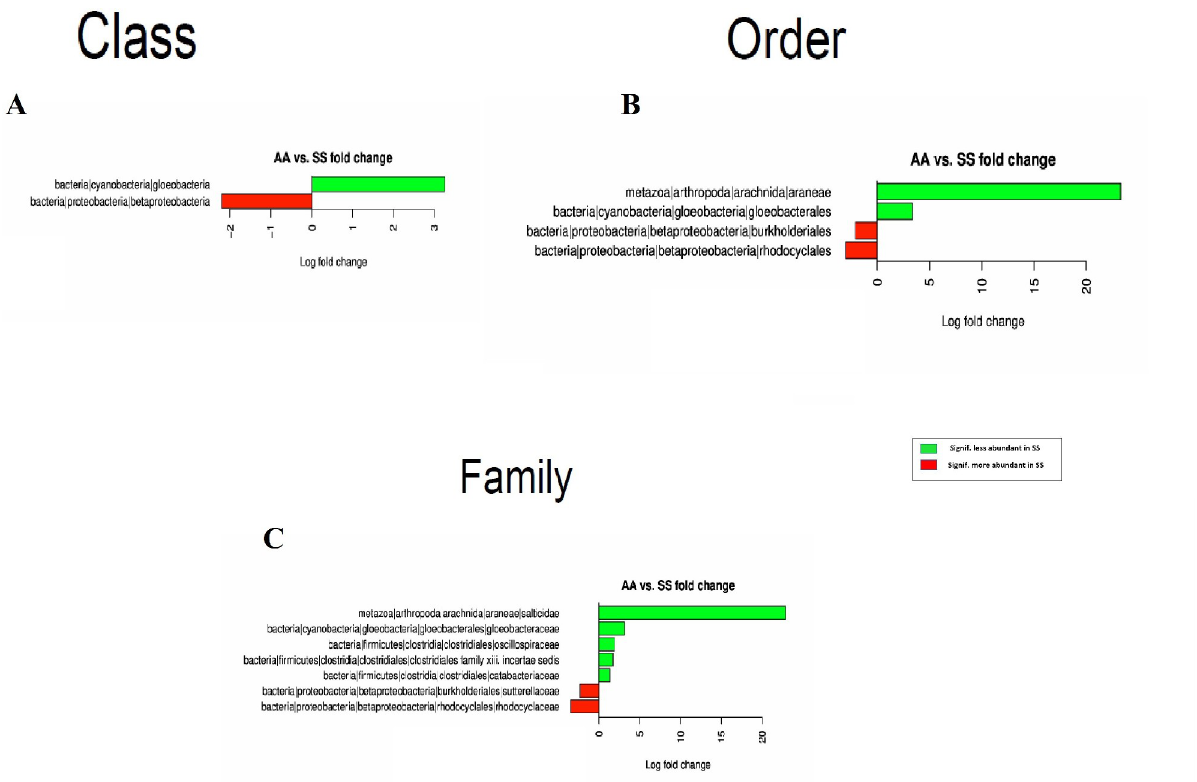
Fig 5. Differential bacterial Classes (A), Orders (B) and Families (C) between SS and AA Townes mice stool samples.